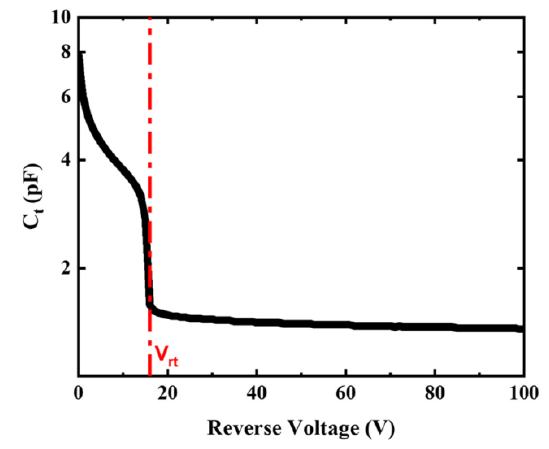
Figure 5. Capacitance versus reverse voltage of the Si